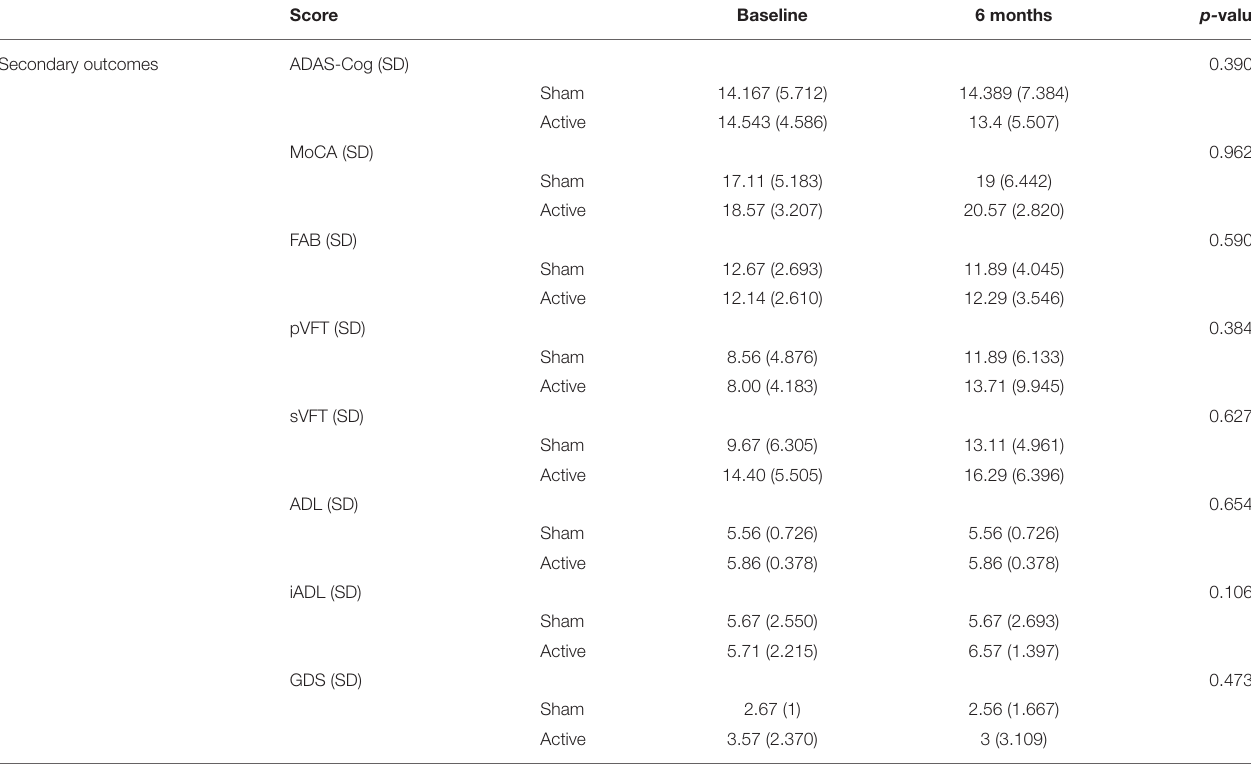
TABLE 2 | Secondary outcomes in baseline and after 6 months of treatment of participants in both the sham FGMS and active FGMS groups. Score Baseline 6 months p-